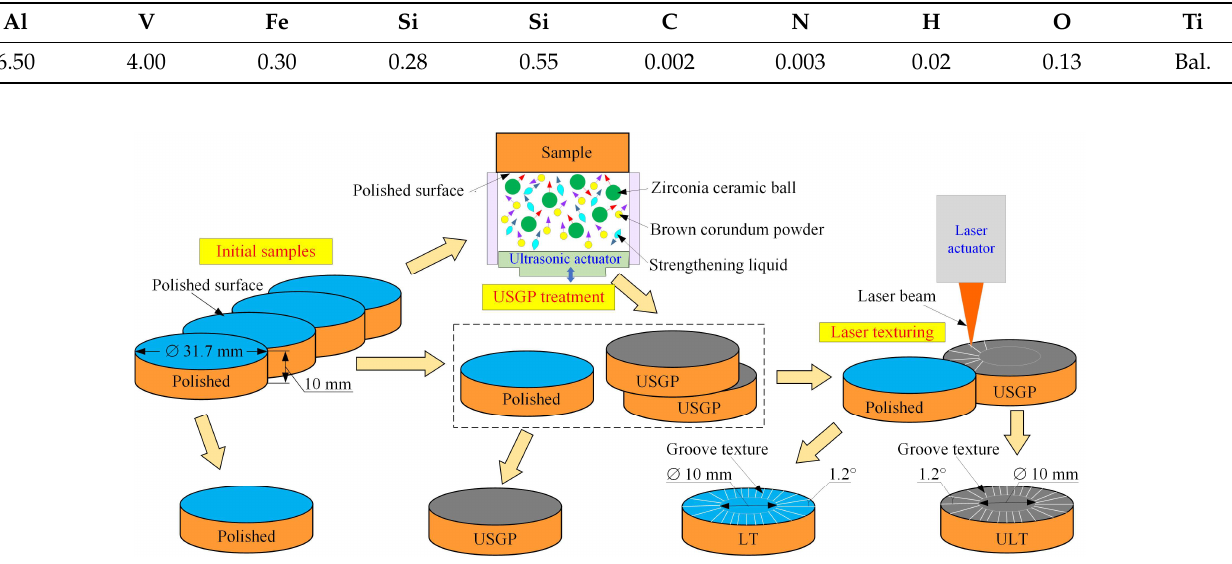
Figure 1. The geometrical parameters of samples.